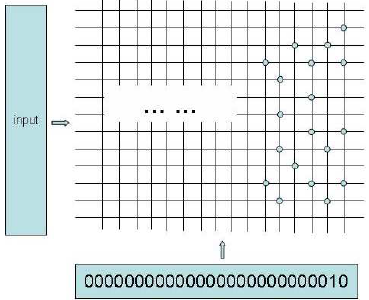
Fig. 4. Store the each image into a column one by